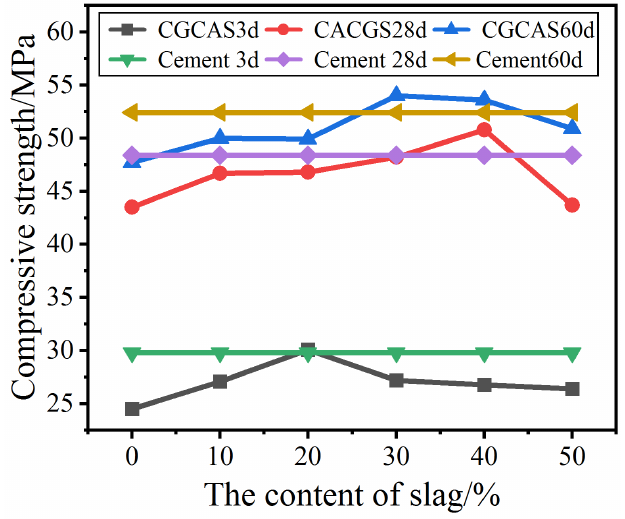
Figure 4. Compressive strengths of mortars added with gangue – slag admixture.